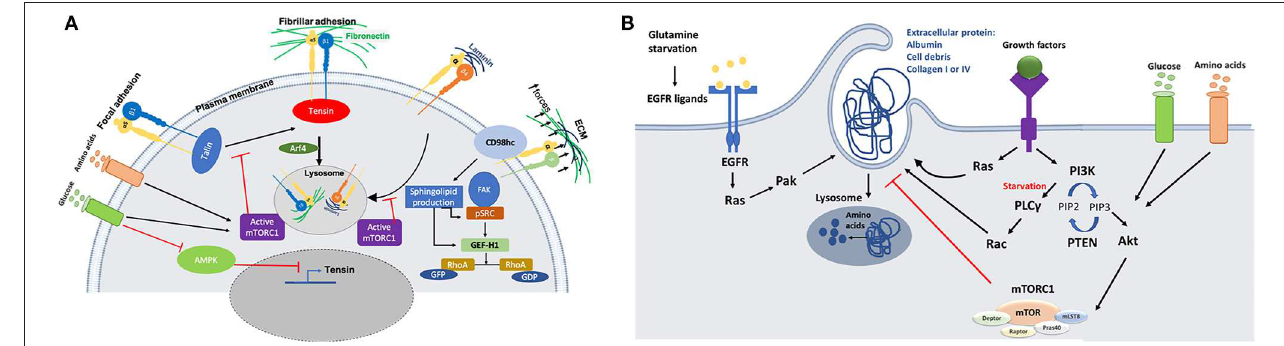
FIGURE 2 | (A) Schematic representation of the crosstalk between integrins trafficking and cell metabolism. Nutrient starvation induces ligand (fibronectin or Laminin)-bound integrin internalization through mTORC1 deactivation. On the other hand, activation of AMPK during starvation inhibits tensin expression, opposing integrin activation. There is also a link between integrin mechanosensing and sphingolipid production through CD98hc protein, which is an integrin co-receptor sensing mechanical forces. Activation of CD98hc induces sphingolipid production leading to activation of Src and GEF-H1 upstream of RhoA. (B) Schematic representation of the molecular mechanisms through which nutrient starvation controls macropinocytosis. Macromolecules internalization under nutrient starvation is induced through Ras and growth factor dependent mechanisms. Amino acids extracted from protein uptake can be used to feed the TCA cycle to make ATP or they may be used to make other